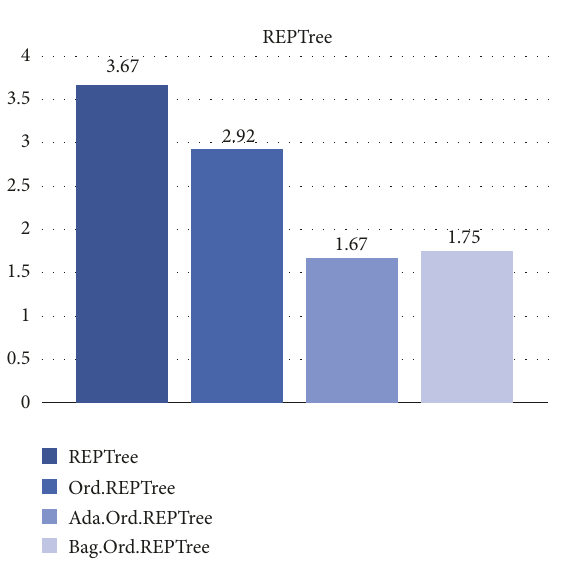
Figure 7: The average ranks of REPTree algorithm with ordinal and ensemble-learning